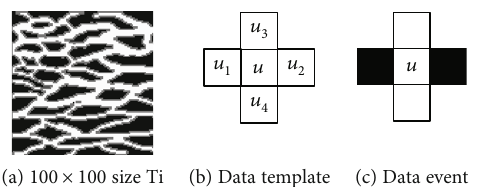
Figure 1: Example of a training image, a data template, and a data event.